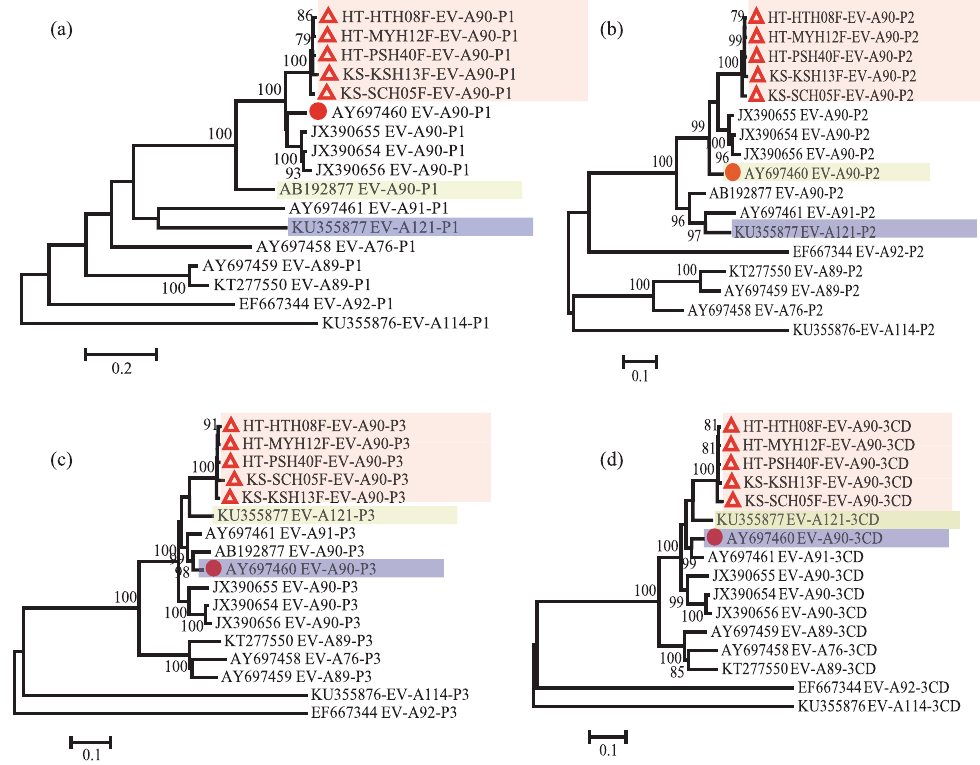
Figure 3. Phylogenetic tree of genetic fragments for EV-A90 and other similar serotypes, including P1, P2, P3 and 3CD, were illustrated in figure ( a – d ). Isolates in this research were marked with and the prototype of EV- A90 (BAN00-10399) was marked with . The phylogenetic tree was reconstructed using maximum likelihood method, in which GTR + I + G model was used in P1 fragment and TN93 + I + G model was used in the rest fragment. We also put forward a hypothesis between the major parental type (yellow) and the minor parental type (blue) because of recombination.